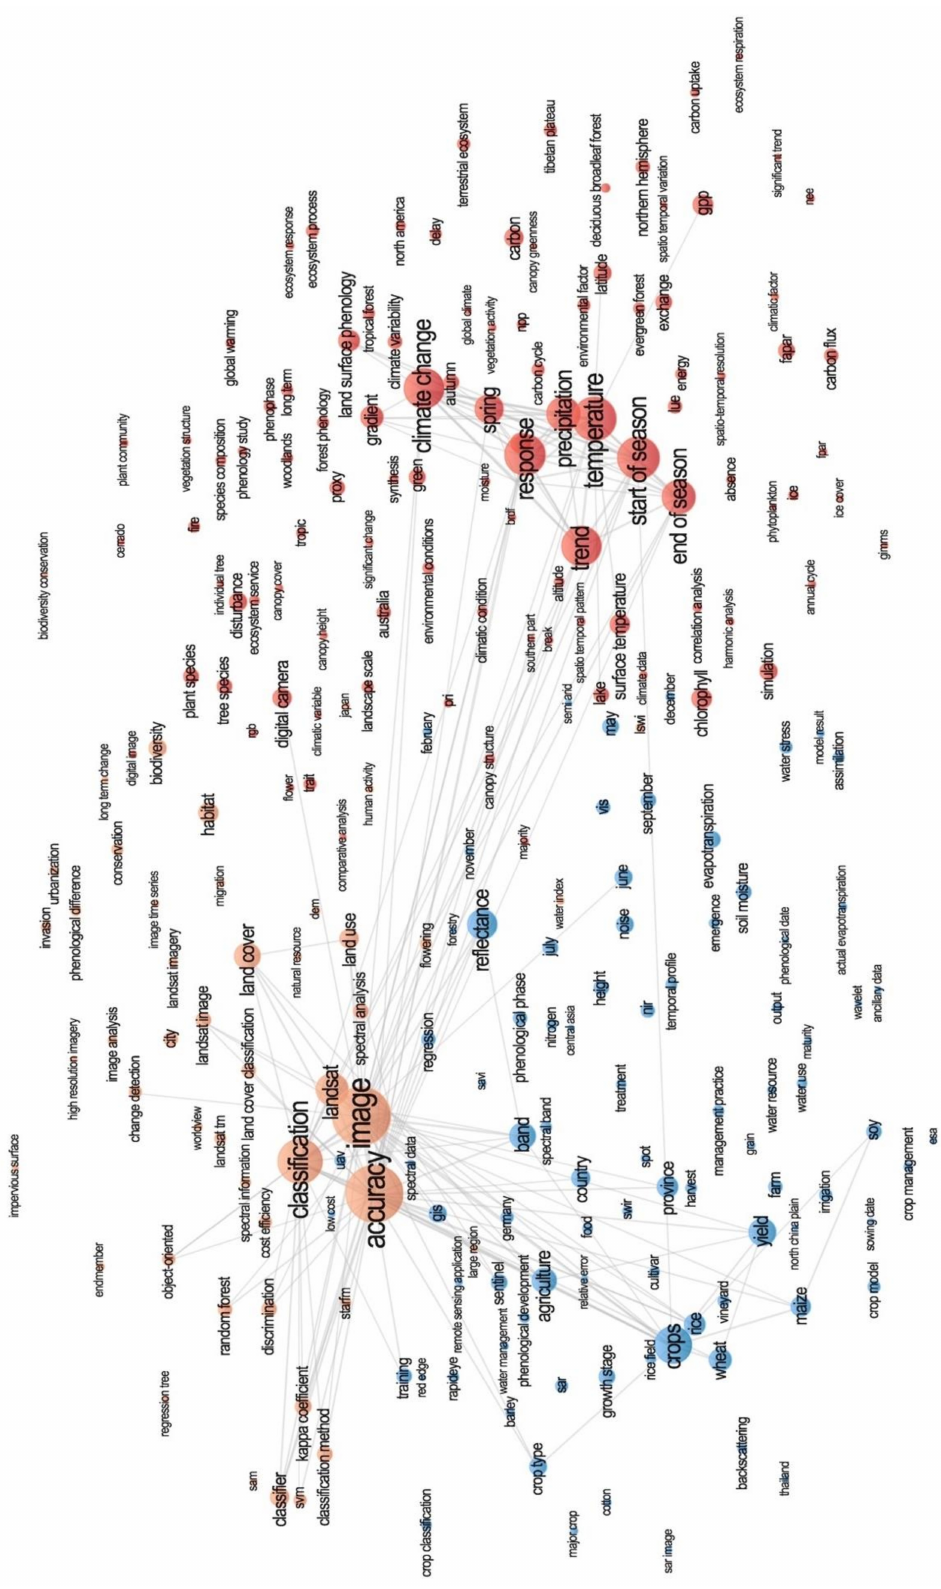
Figure 6. Network mapping and clustering of terms in 2009–2018. Since it is a 3-d map, not all the terms are represented. Lines represent the link strength between two terms (minimum link strength = 10). Red cluster = phenology / climate topic; Blue cluster = agriculture topic; Orange cluster = classification